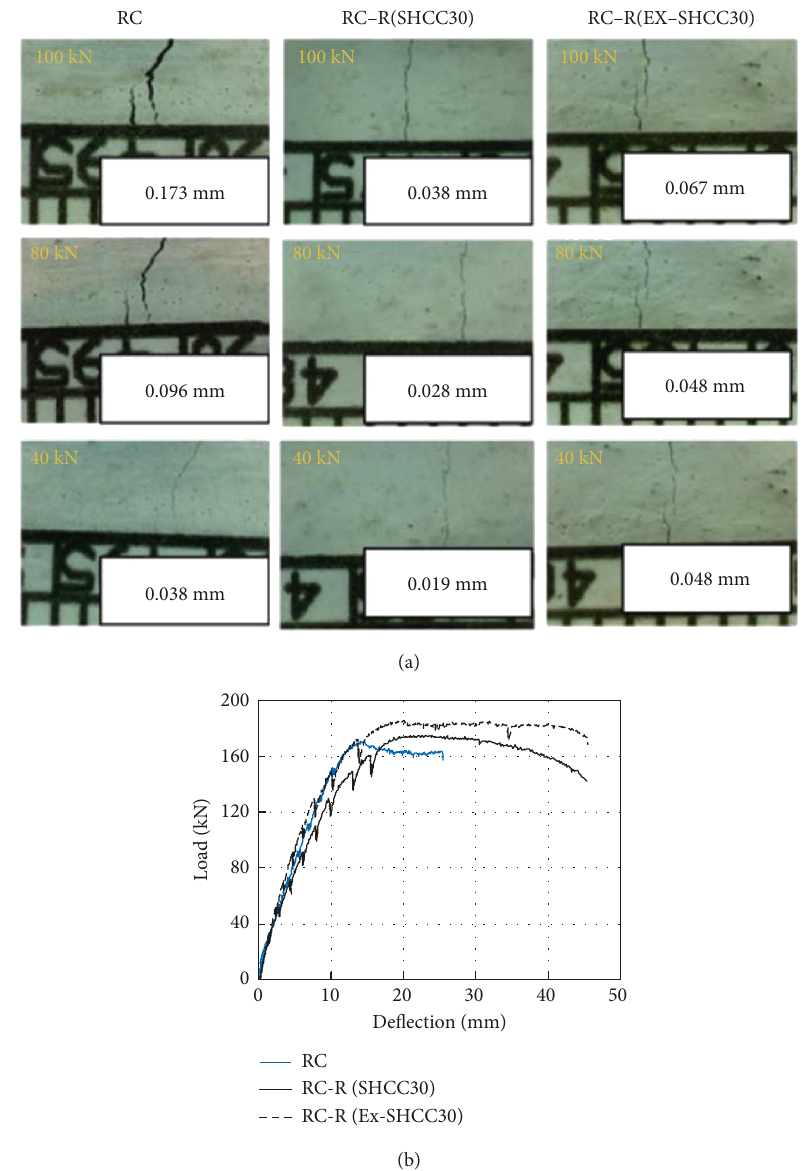
Figure 8: Observed behavior of repaired beam specimens versus control specimen. (a) Variation in crack widths. (b) Responses of beam